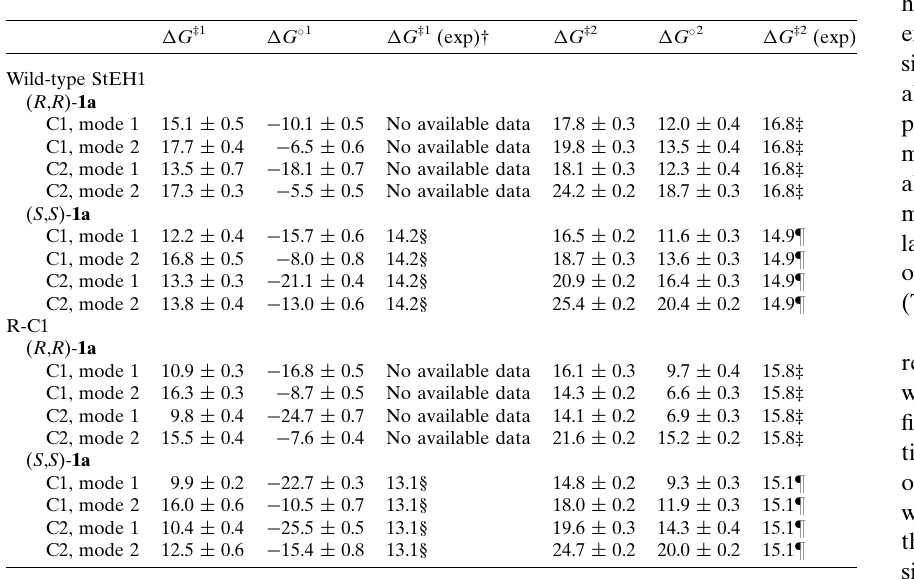
Table 3 Experimental and calculated energy barriers for hydrolysis of the different enantiomers of 1a by either wild-type StEH1 or the R-C1